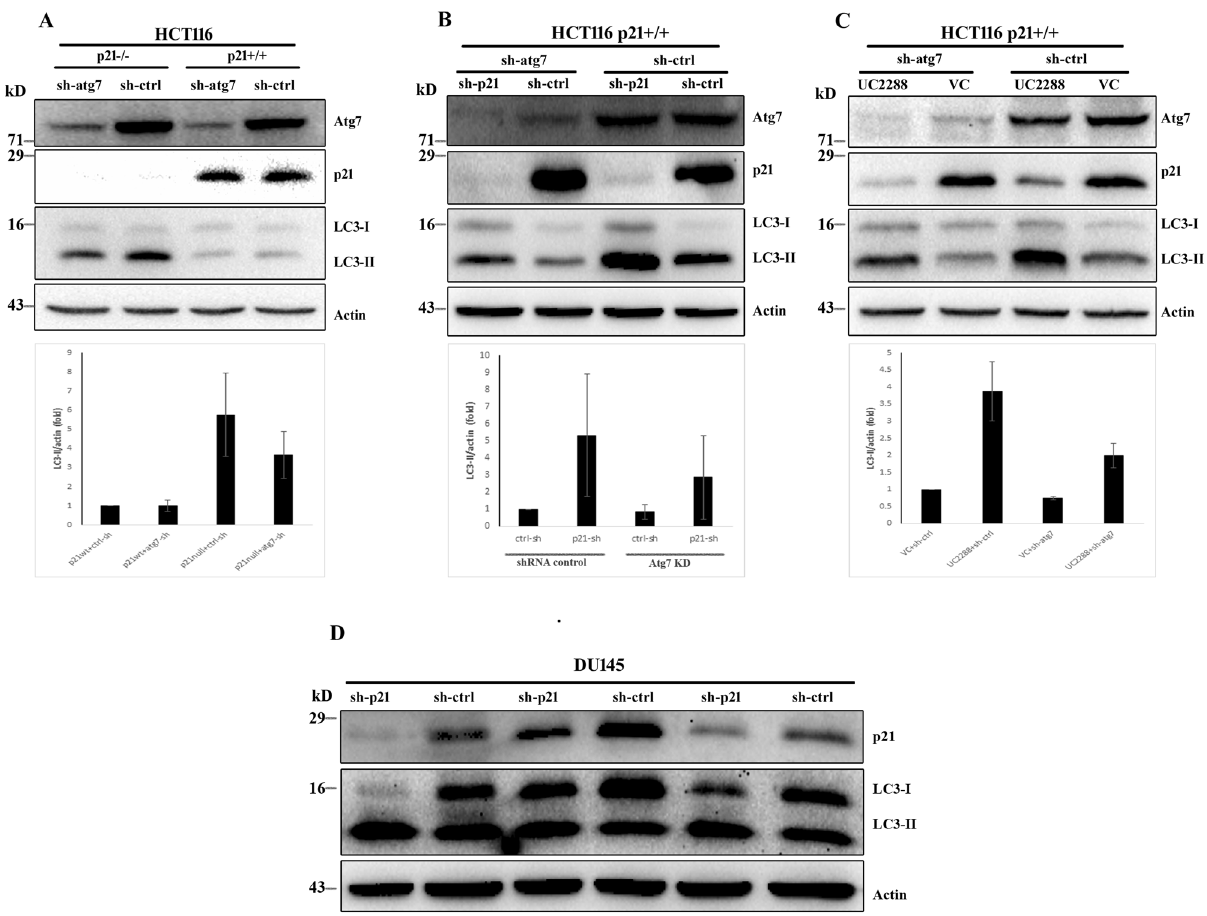
lysates after transduction with control or p21